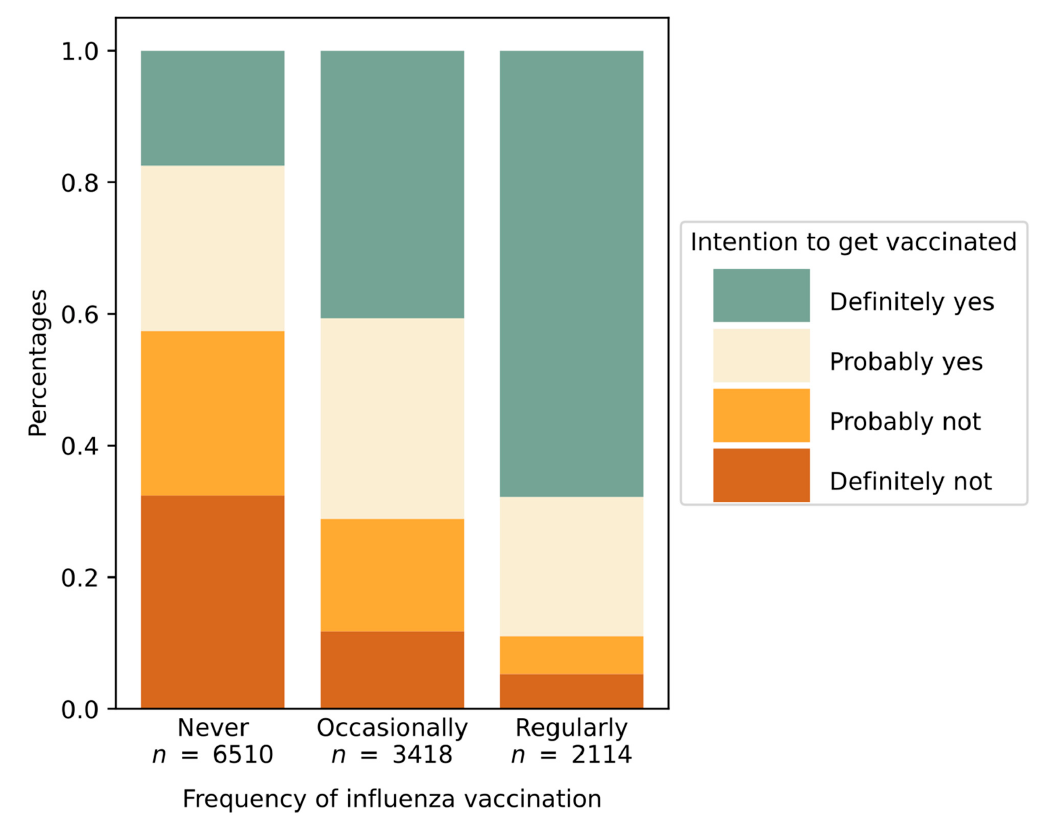
Figure 3. Intention to get vaccinated grouped by frequency of past influenza vaccination with shown subdivision regarding the COVID-19 vaccination intention. Respondents who knew someone who was hospitalized or died due to the virus (44% of all respondents) were more likely to accept vaccination (66%) as compared those who did not know anyone with that experience (53%) ( p < 0.001, Chi Square = 202.946, Contin- gency Coeff. = 0.129) .